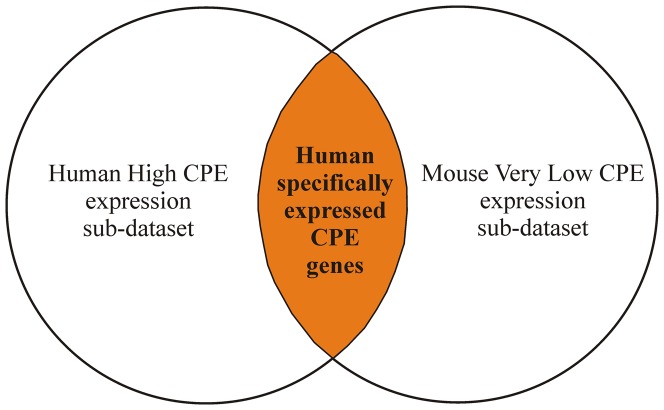
Human specifically expressed CPE genes.Schematic graph to illustrate the determination of the human specifically expressed CPE genes compared to mouse CPE. We compared the “Human High CPE expression sub-dataset (>90th P)” with the “Mouse Very Low CPE expression sub-dataset (<10th P)” and selected the common genes that showed consistent hybridization signals and had a formal GenBank NM number. These genes, indicated in the orange overlapping area, are called the human specifically expressed CPE genes.